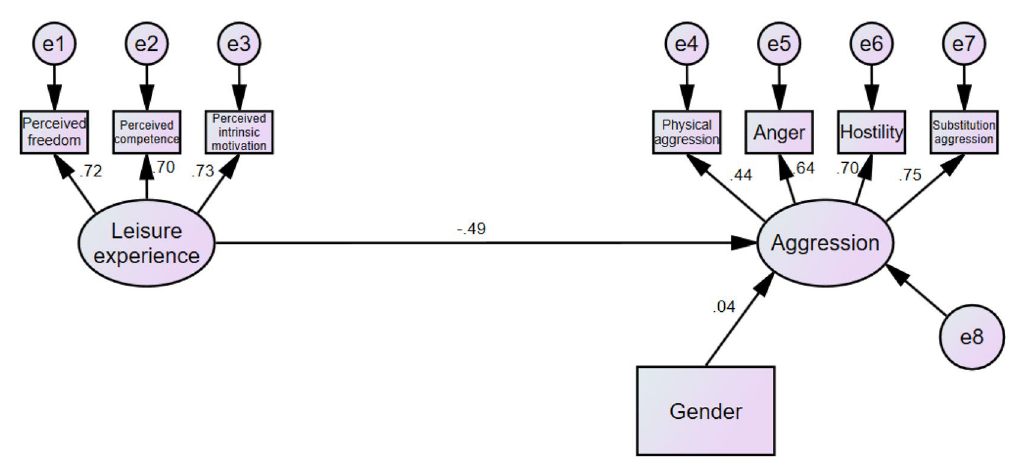
Figure 2. Direct effect of leisure experience on aggression (Model